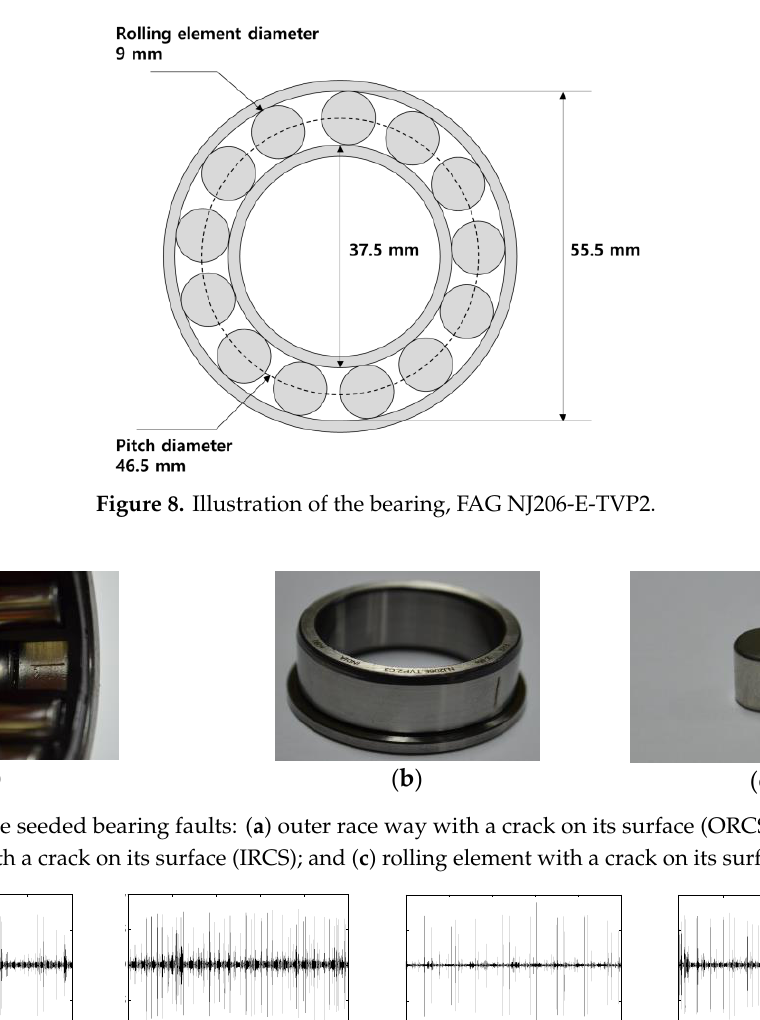
Figure 7. The illustration of the bearing fault simulator: ( a ) the diagram of the bearing fault simulator and ( b ) the photographs of the bearing fault simulator.